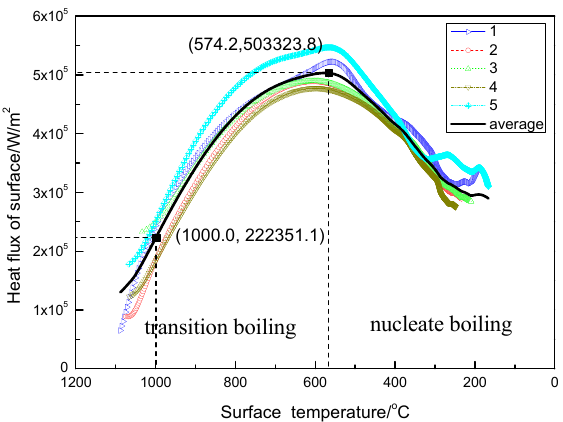
Figure 9. Relationship between surface temperature and heat flux.